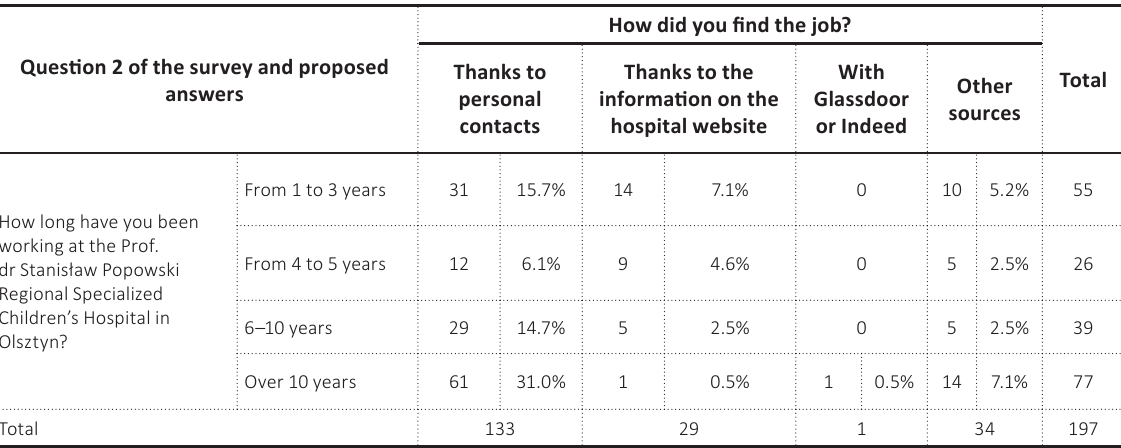
Table 3. Analysis of answers to questions 2 and 3 of the